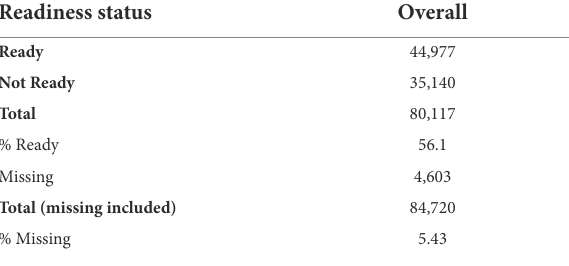
TABLE 1 Overall school readiness rates and by